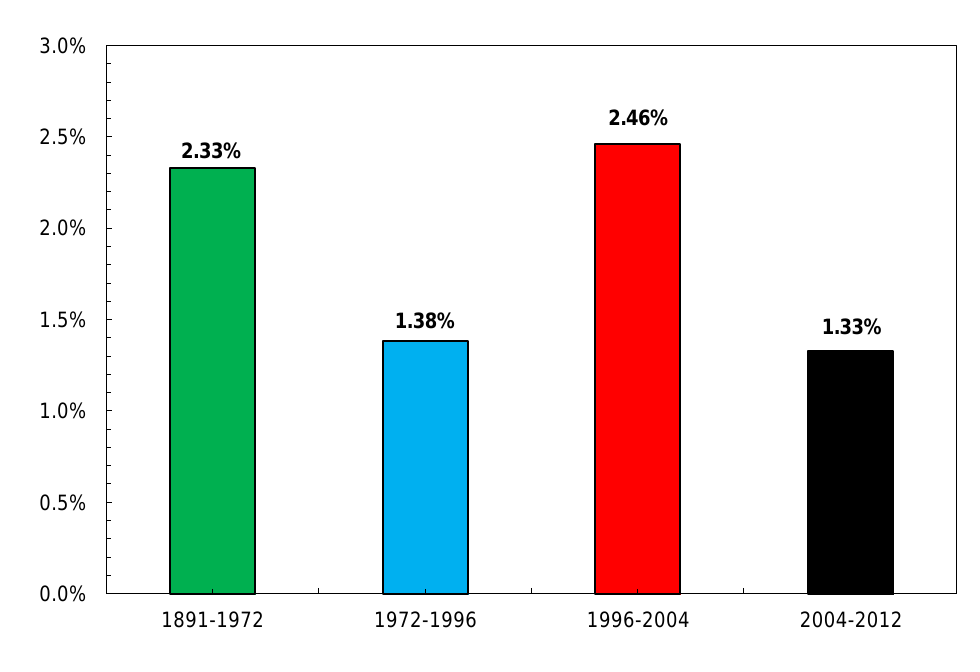
Figure 6. The average growth rate of U.S labor productivity over selected intervals, 1891–2012 (from [8]).